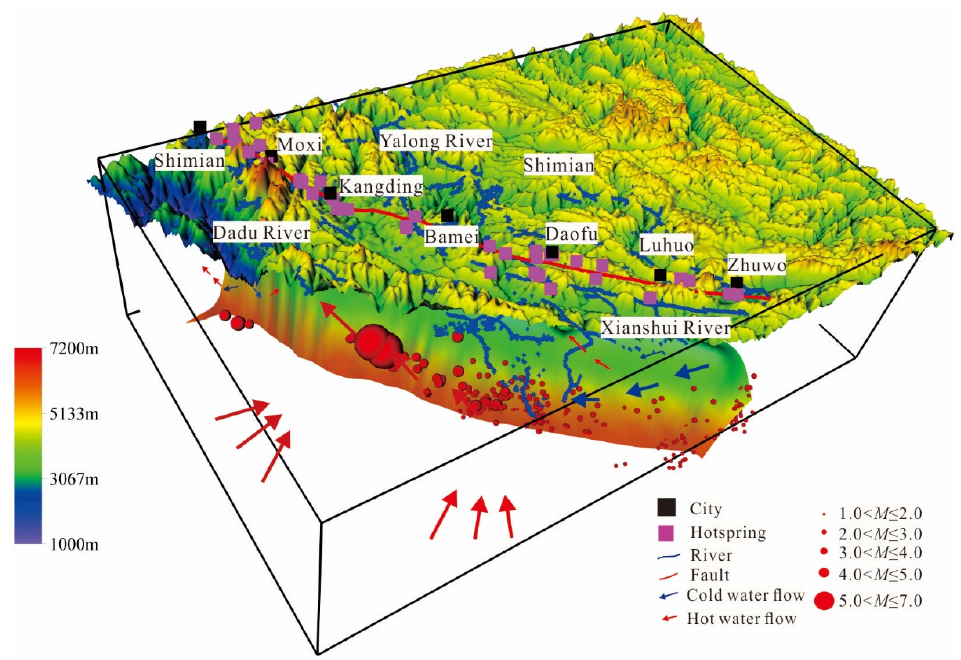
Figure 10. Conceptual model of the origin of groundwater and the hydrogeochemical cycling process in the XSHF. in the